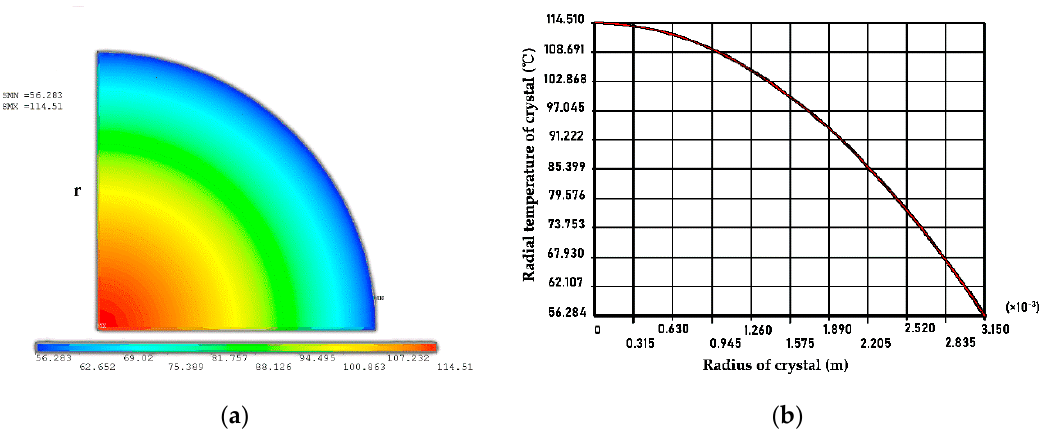
Figure 5. Validation of temperature models: ( a ) The radial temperature profile, ( b ) calculated temperature curve.